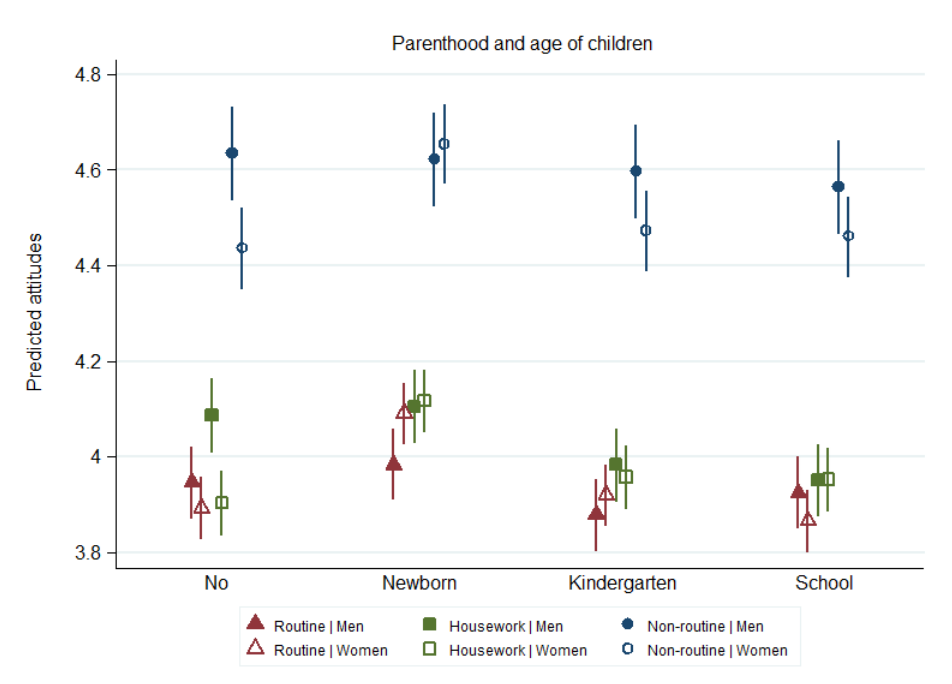
Figure 4 : Predicted attitudes towards housework by vignette couples’ parental